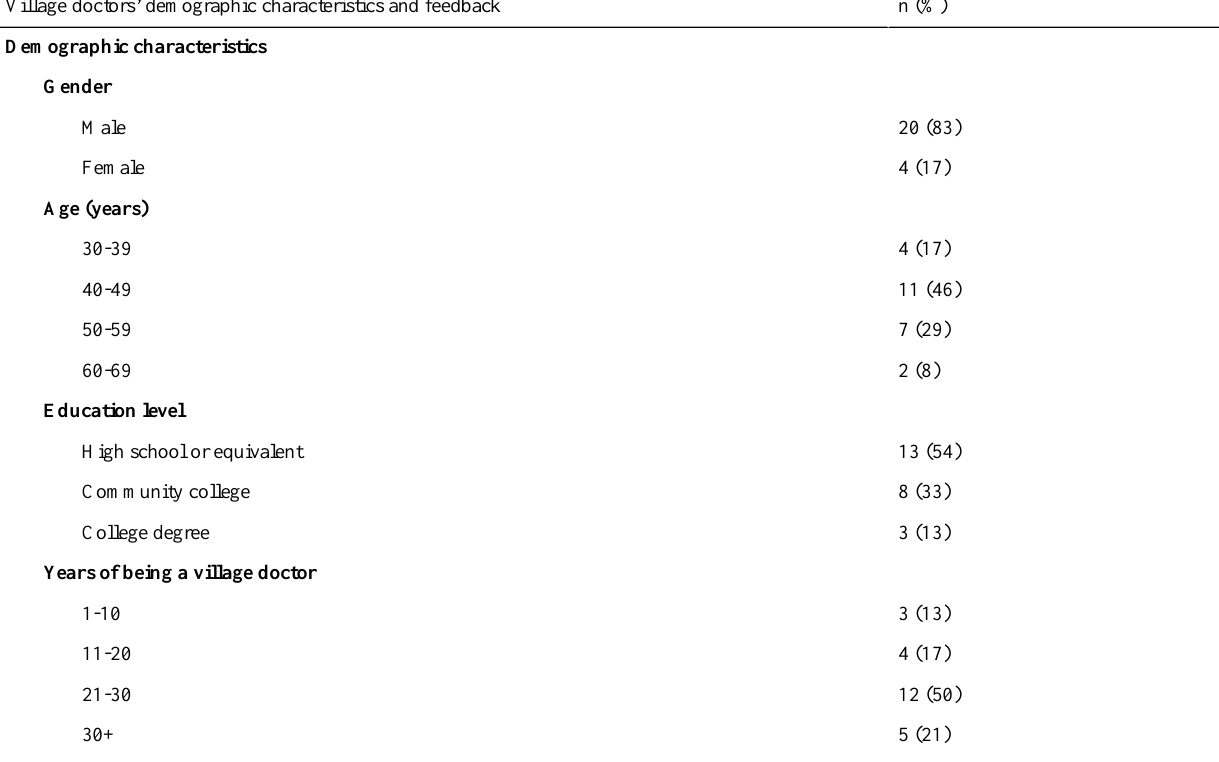
Table 1. Village doctor’s survey responses at 12 months of the main trial